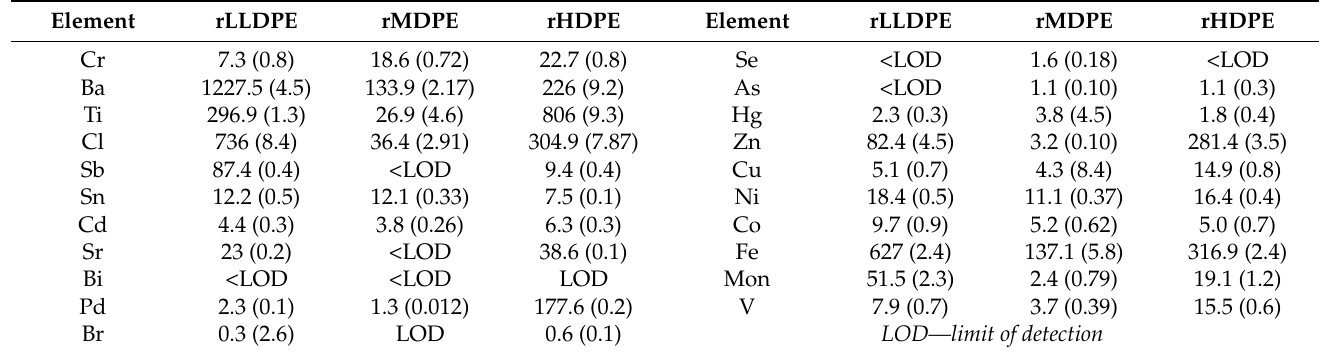
Table 5. Results of residual metal additives in recycled PE plastics (LLDPE, MDPE, and HDPE).